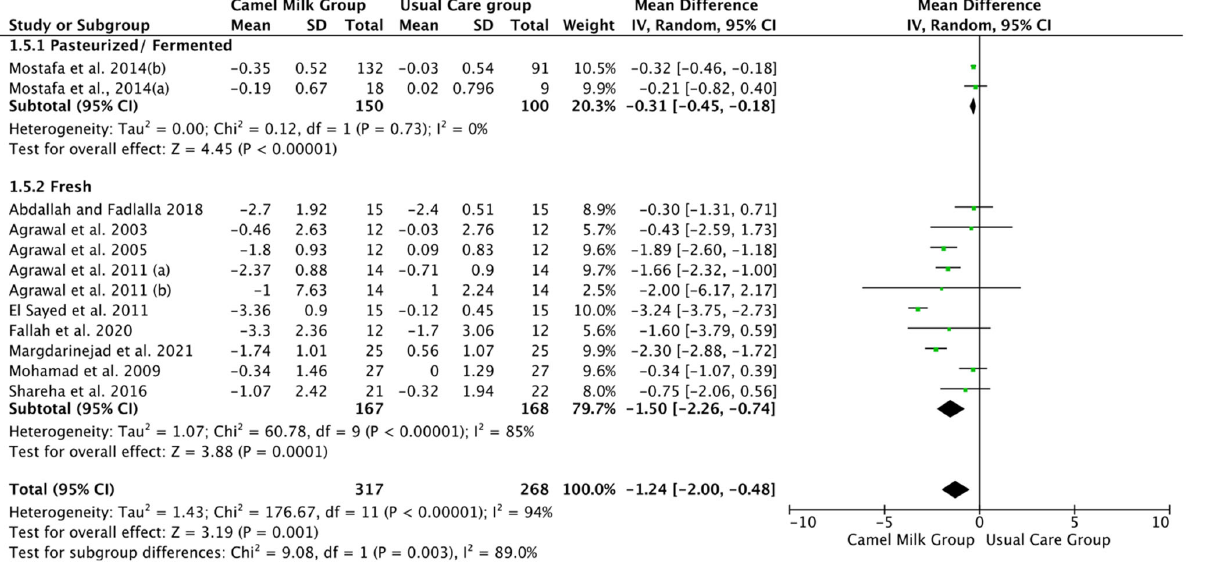
Figure 14. Forest plot for the effect of CM intake on HbA1C levels based on the type of CM. Note: Mostafa and Al ‐ Musa, 2014 (a) for T1DM and (b) for T2DM.